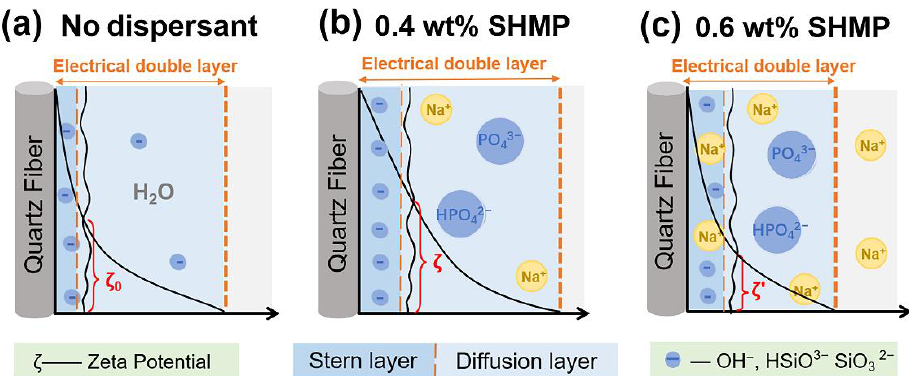
Figure 4. Schematic mechanism of the zeta potential of fiber slurries with different SHMP contents. ( a ) 0, ( b ) 0.4 wt% and ( c ) 0.6